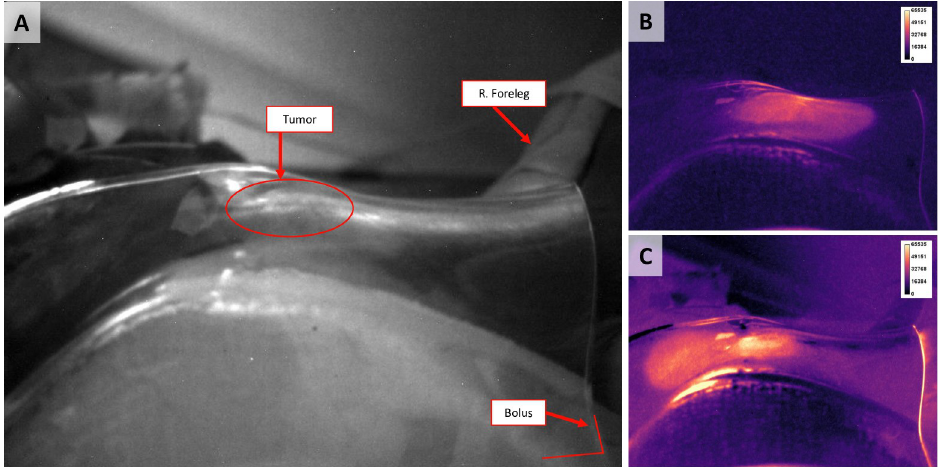
Fig 3. Anatomical, Cherenkov and CT images of the first canine subject. A) Representative low-light anatomical (non-Cherenkov) image of canine subject 1 (see Table 1 ), acquired during the second subfraction. The tumor, foreleg and the caudal ventral edge of bolus are labeled in red. B) Here, the same dog is depicted but with the Cherenkov images. The gantry was angled at 40˚. C) The Cherenkov image corresponding to the anatomical image in A). The gantry angle is at 290˚, and there is a clear dependence of Cherenkov signal on the gantry